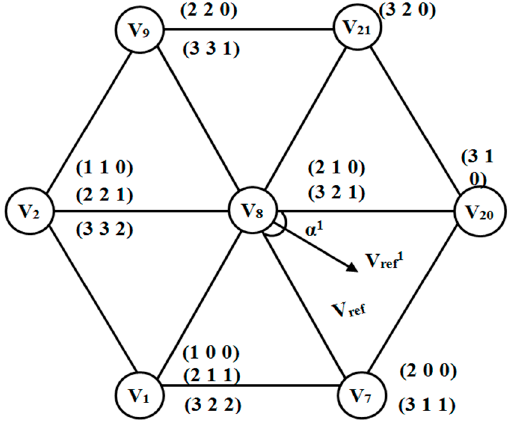
Figure 7. Two-level space vector representation.